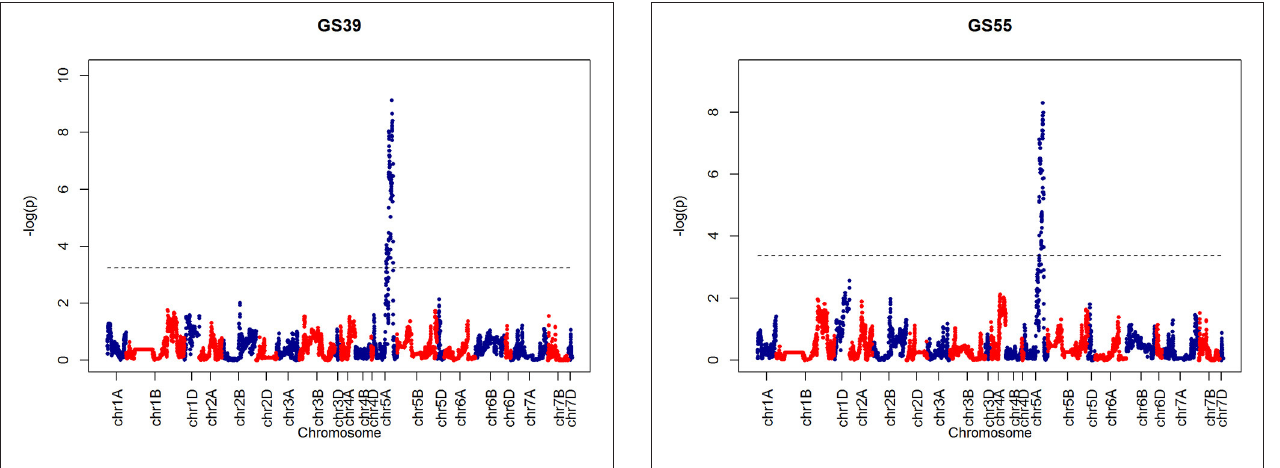
FIGURE 8 | QTLs markers for the trait GS55. Dashed lines indicate threshold (FDR < 0.05,